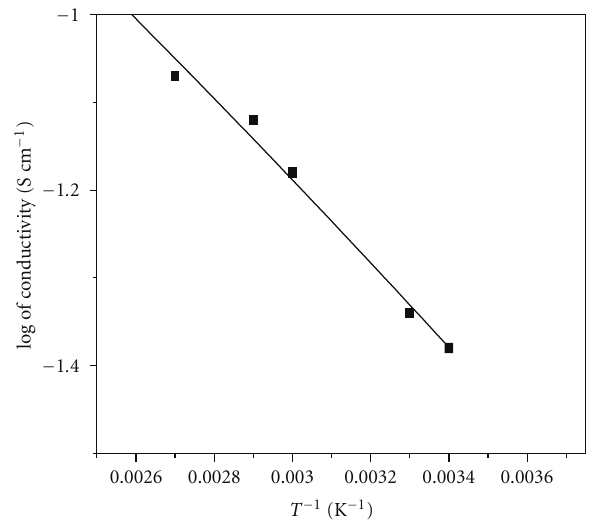
Figure 5: Temperature-dependent proton conductivity of graphite oxide membrane.